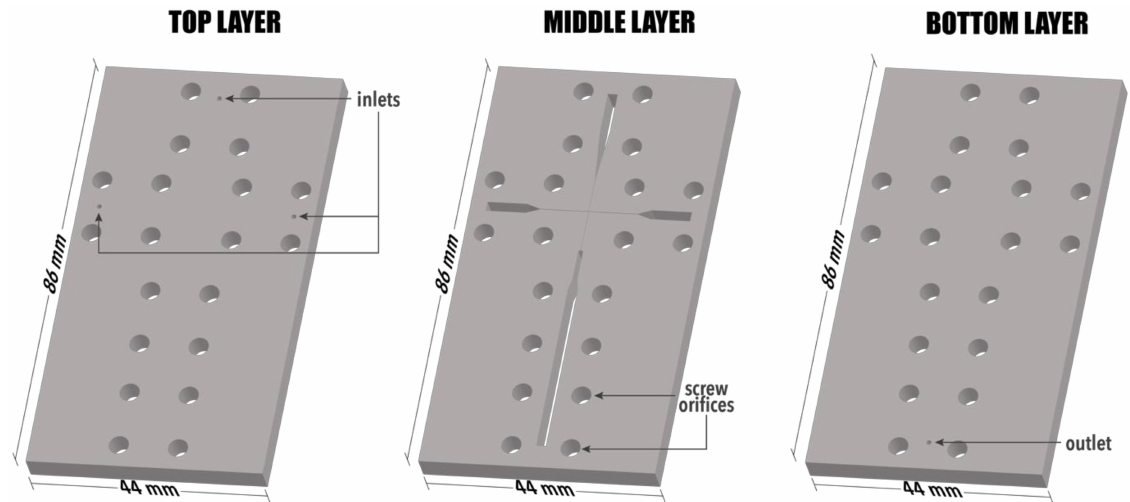
Figure 1. Configuration of the three layers comprising the LoC device.